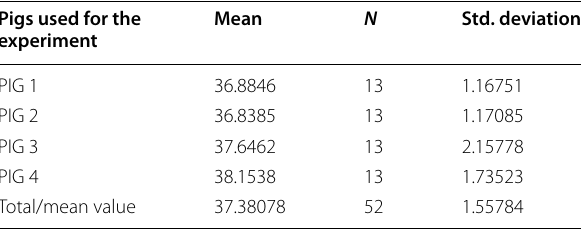
Table 2 Descriptive statistics of the body temperatures of all the